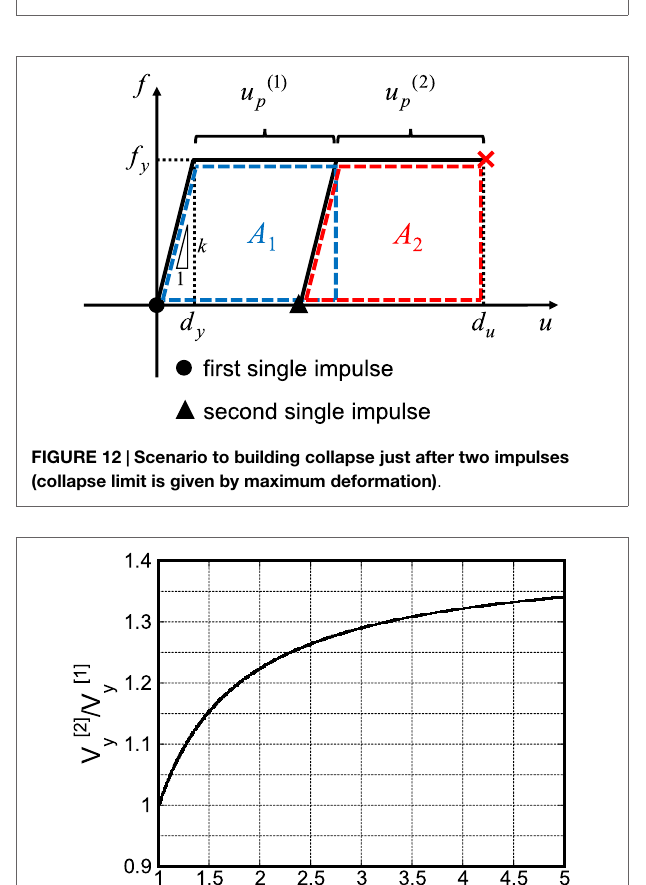
FIGURE 11 | Scenario to building collapse just after single impulse (collapse limit is given by maximum deformation) .